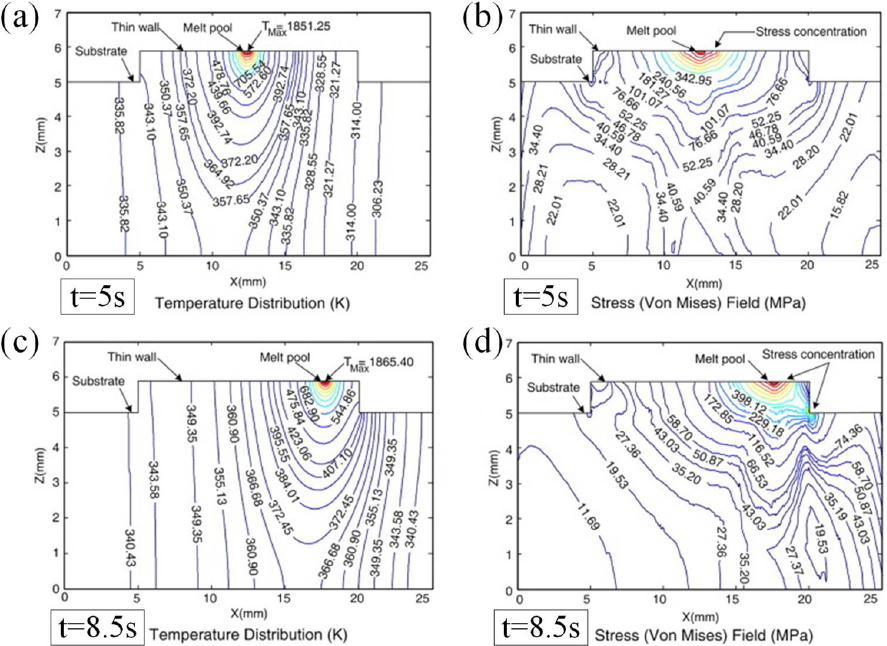
Figure 11. ( a , c ) Thermal field (isothermal contours), ( b , d ) stress field (Von Mises) for the second-layer deposition at different times on the surface normal to y = 0 (Reprinted from ref. [43], copyright (2009), with permission from